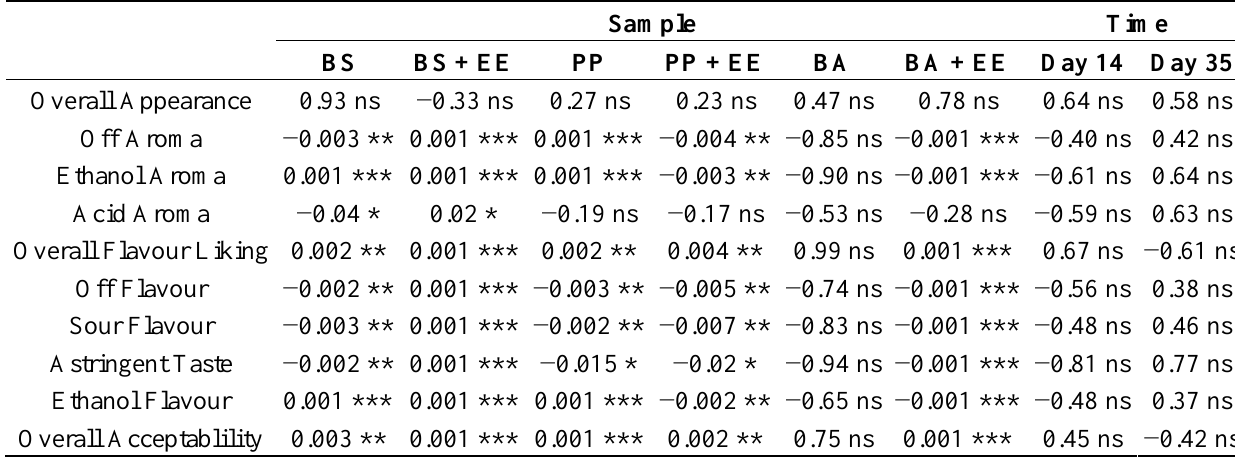
Table 3. Significance of estimated regression coefficients (ANOVA p -values) for the relationships of sensory terms as derived by jack-knifing uncertainty testing of ready cooked